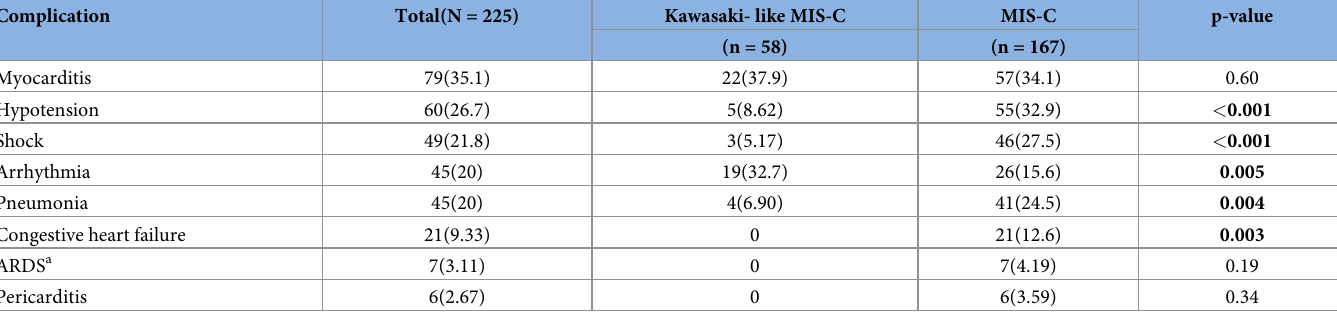
Table 3. Complication in Kawasaki- like MIS-c and MIS-c